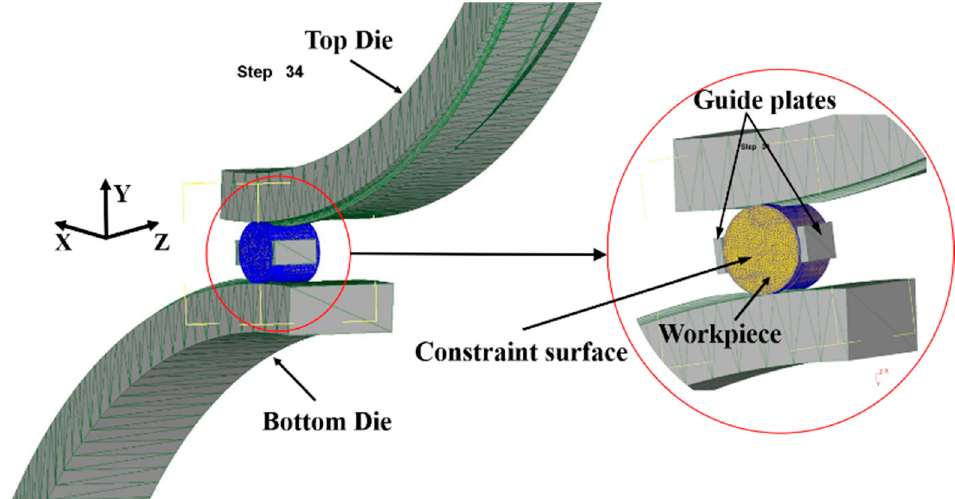
Figure 5. Finite element model.